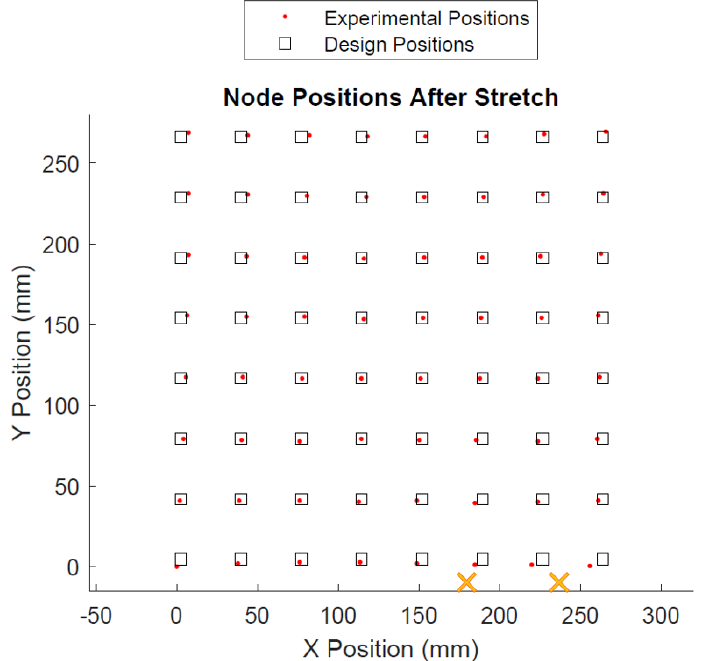
Figure 18. Node positions after Run 2. Xs indicate locations of unopened sacrifice